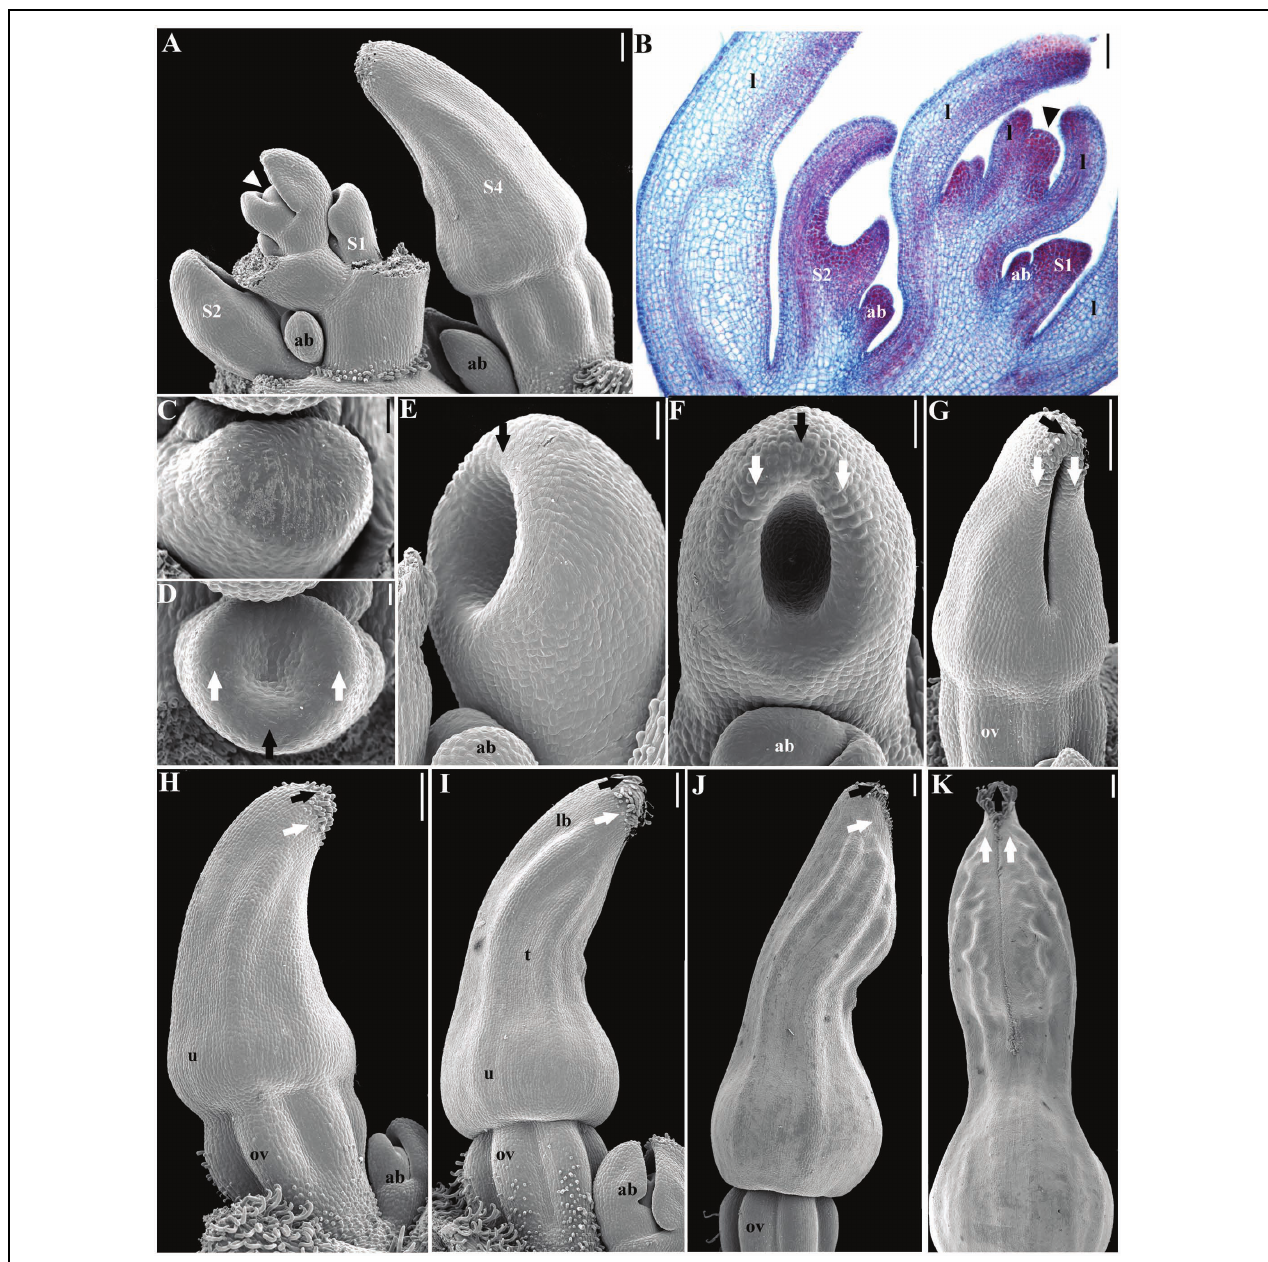
FIGURE 2 | Aristolochia fimbriata, perianth development. (A,B) Shoot apex with floral stages S1 to S4. (C,D) Initiation of sepal primordia (stage S1). (E,F) Elongation of sepal primordia (S2). (G) Perianth closure and ovary (ov) differentiation (S3). (H) Initiation of hooked trichomes (S4). (I) Differentiation of utricle (u), tube (t), and limb (lb) during S5. (J,K) Perianth closure (S6). Black arrows indicate the median sepal; white arrows indicate lateral sepals; arrowheads indicate the shoot apical meristem; ab, accessory bud. Scale bars: (A,B) , (G–K) : 100 μ m; (C,D) : 20 μ m; (E,F) : 40 μ m.